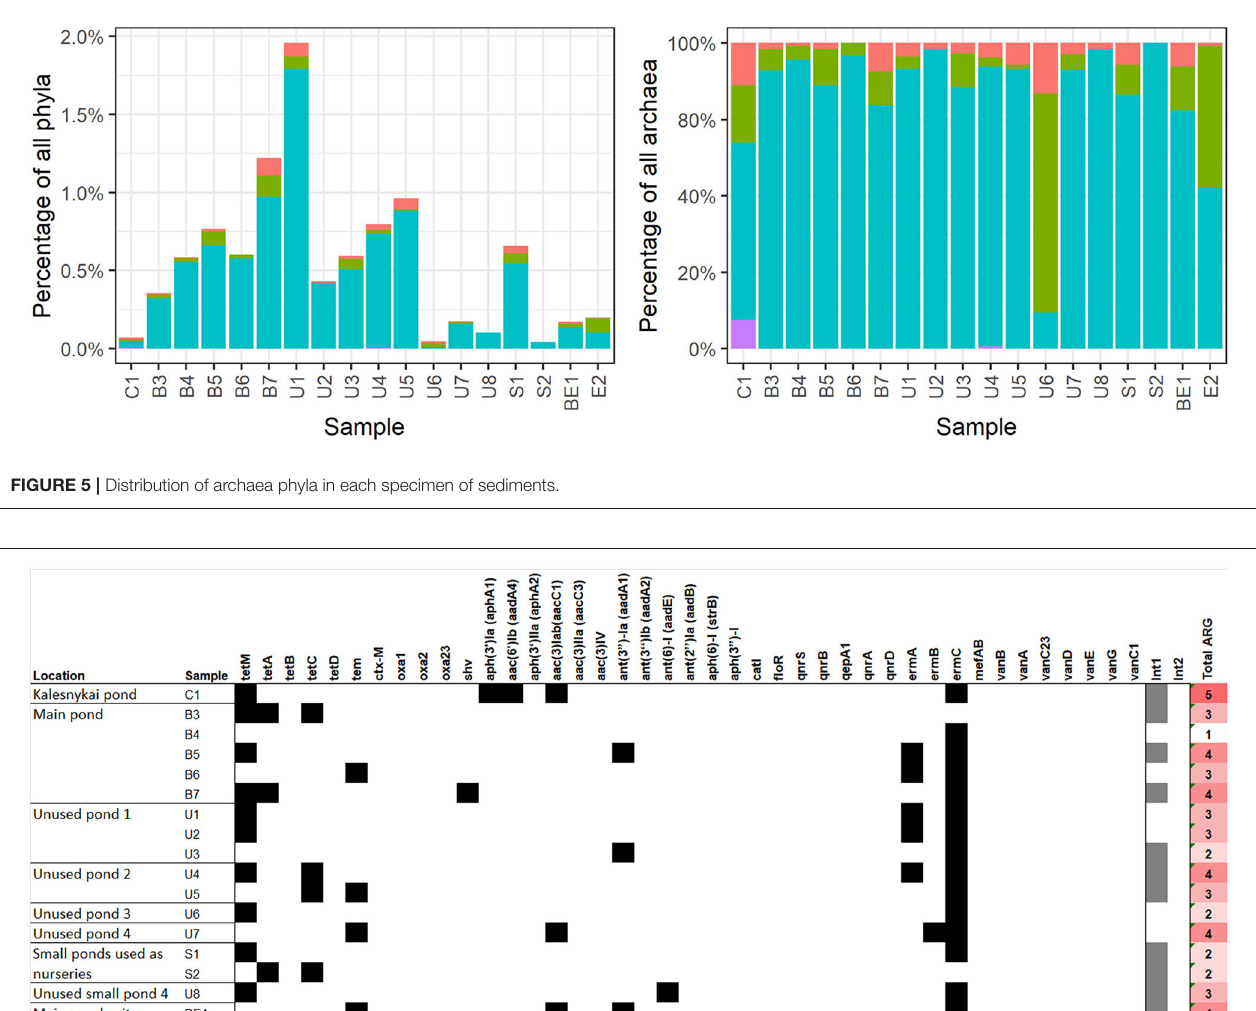
of the species farmed in the ponds and the aquaculture